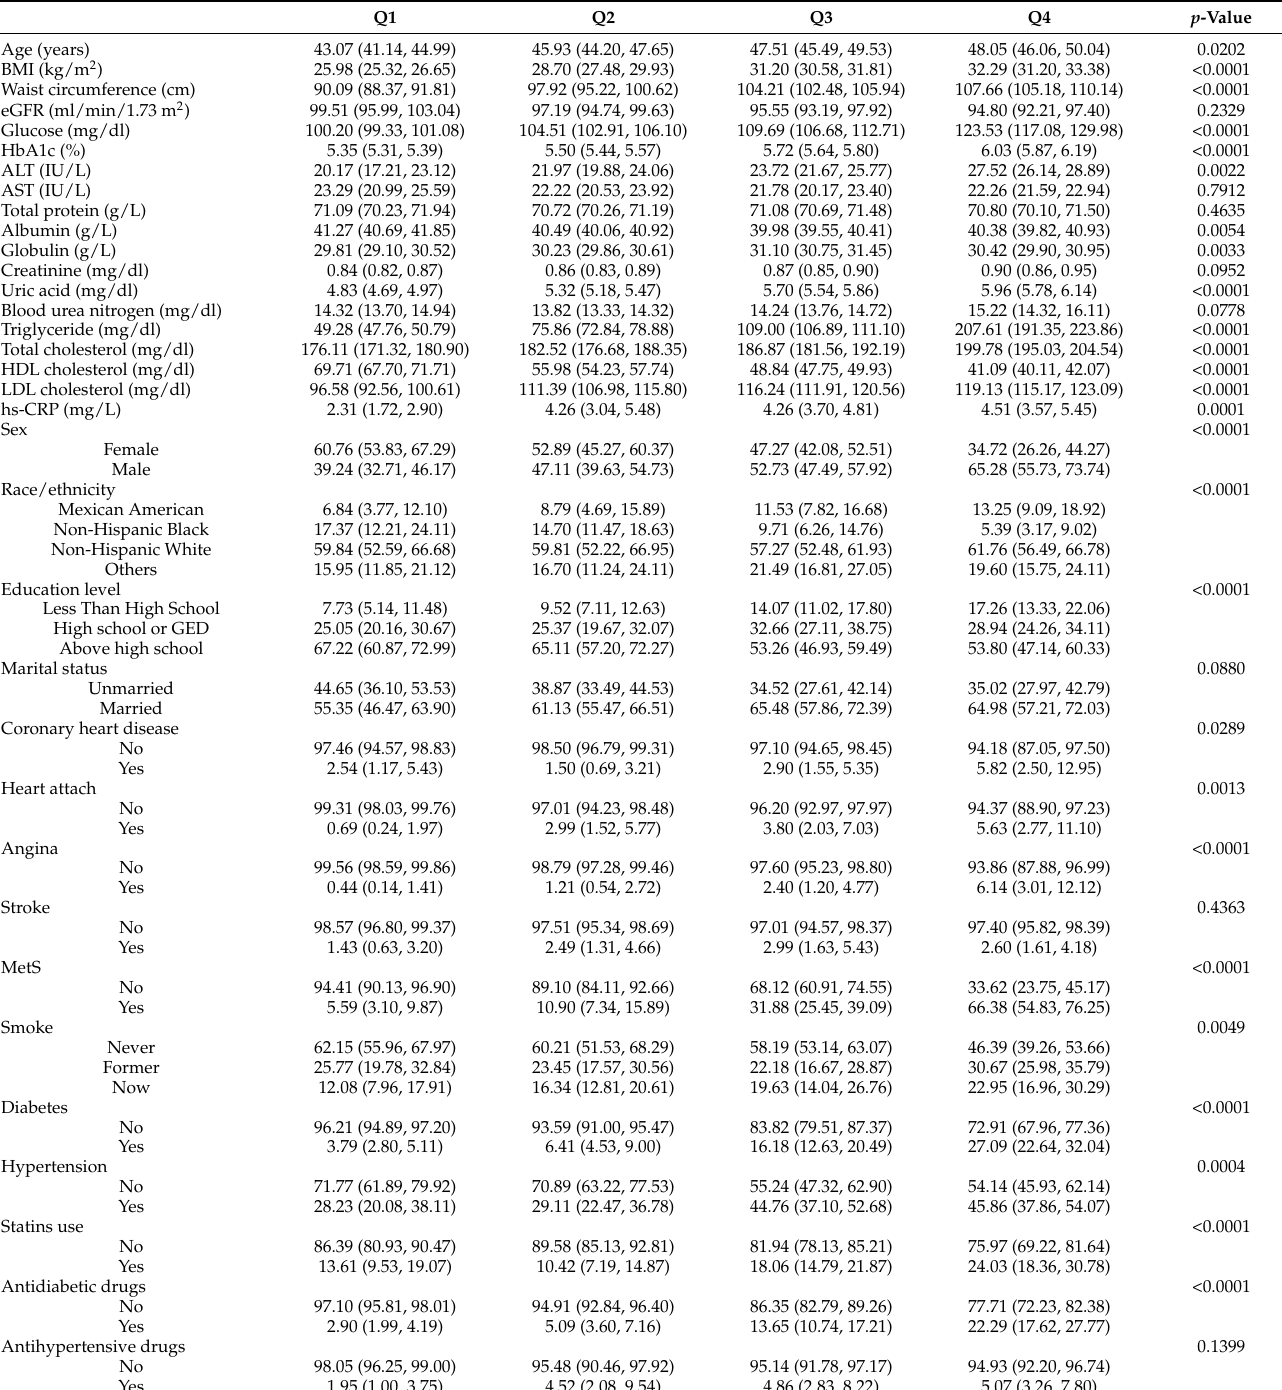
Table 1. Baseline characteristics of included individuals according to atherogenic index of plasma quartiles,